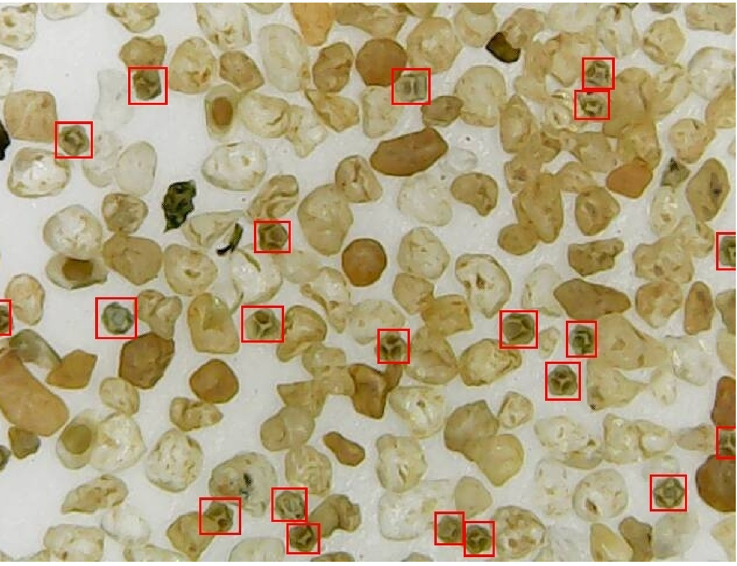
Fig 2. Substrate image captured by the XTRAD USB digital microscope model XT-2036 at a 52x magnification. Each red rectangular bounding box displays a cyst.